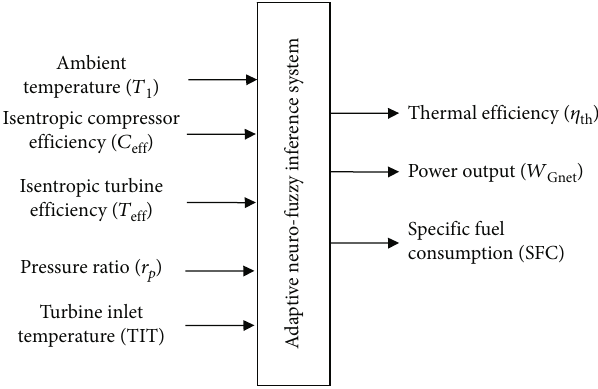
Figure 3: Proposed ANFIS architecture for equivalent GT model.